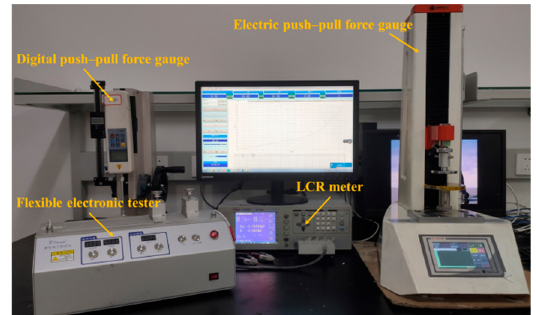
Figure 7. Performance test device of sensor.